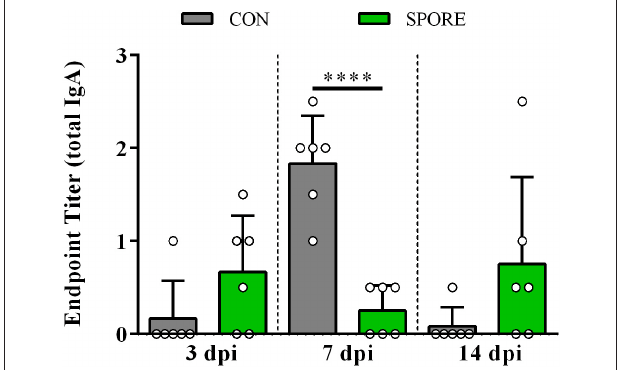
FIGURE 7 | Total IgA production. Endpoint titers for total IgA were measured in small intestinal scrapings from birds at 3, 7, and 14 days post-inoculation (dpi) via ELISA. Assays were performed in experimental duplicate. **** P <